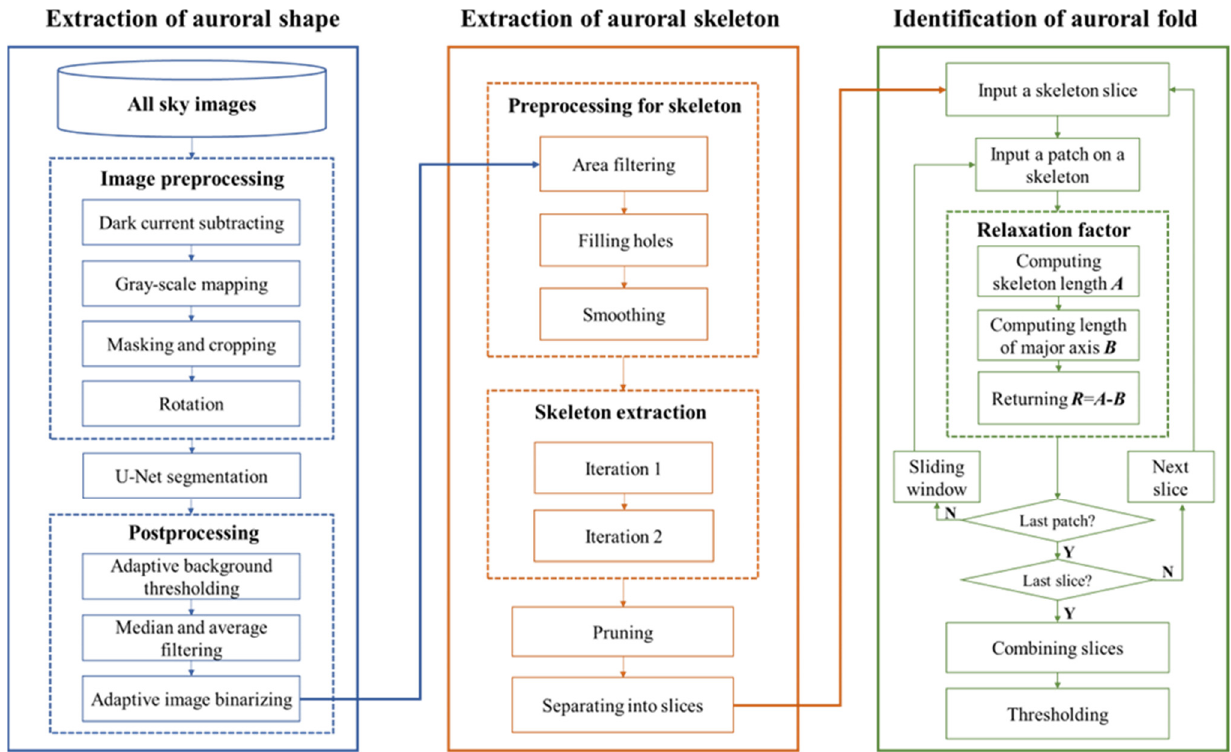
Figure 1. Workflow of the proposed aurora fold identification method comprising three modules. A U-Net segmentation network is used to find auroras in all-sky images; a skeleton extraction method is used to portray the trajectory of auroral arcs; a local relaxation factor (RF) is applied on auroral skeletons to identify aurora fold structures.